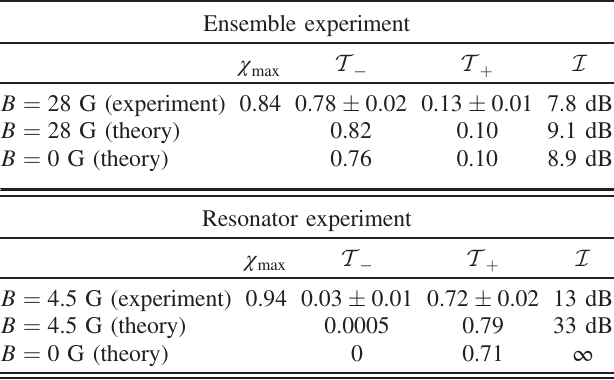
TABLE I. Experimental results and predictions of the trans- missions T − and T and of the isolation I for both the ensemble þ experiment and the resonator experiment. The chirality of the electric field calculated at the position of the atoms is also given. For the ensemble experiment, the predictions are calculated by assuming a mean number of atoms of h N i ≈ 27 . For comparison, we also show the predicted values for the case without magnetic offset